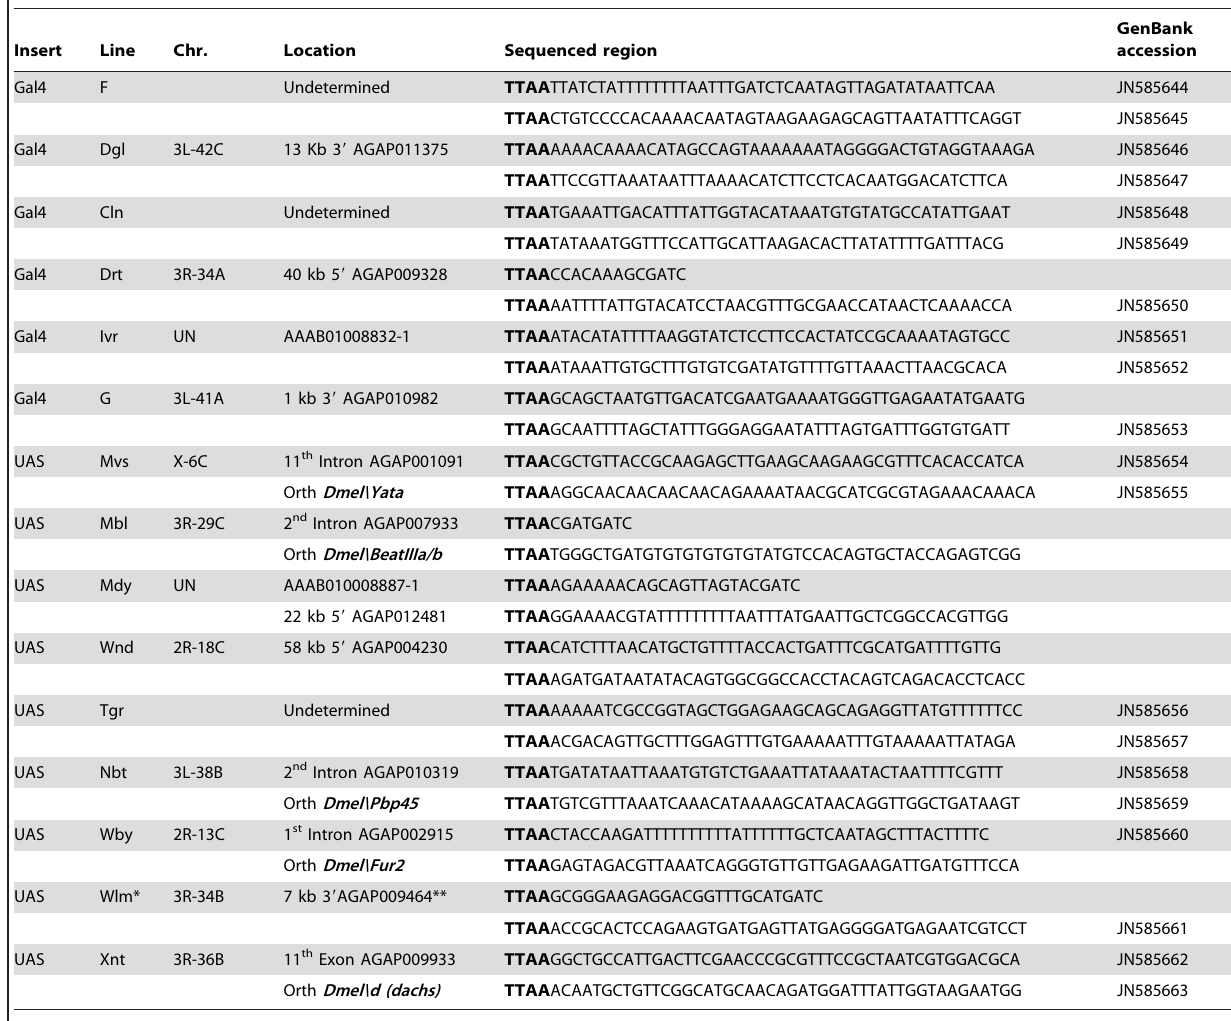
Table 1. Transgene chromosomal insertion